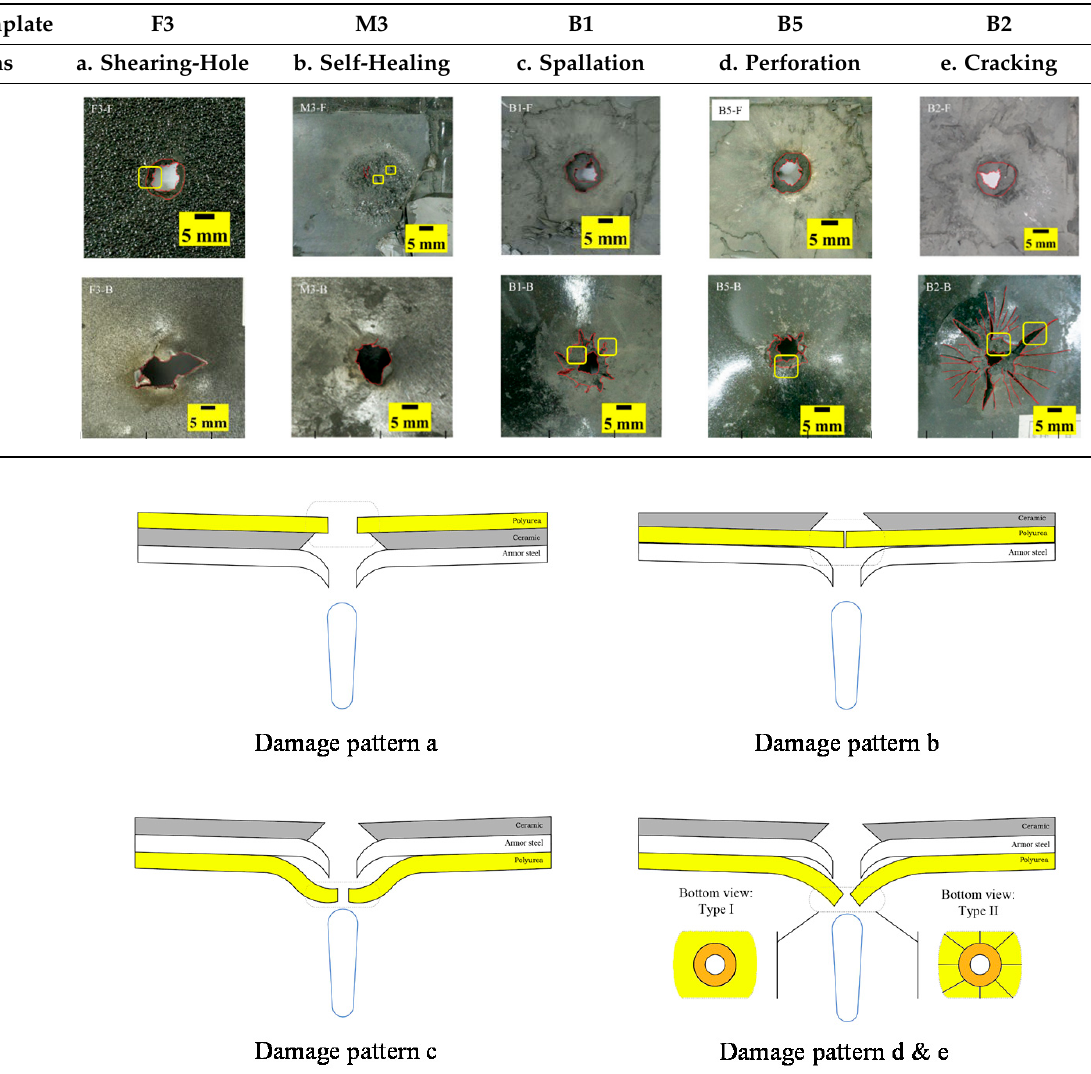
Table 6. Perforation of the targets.